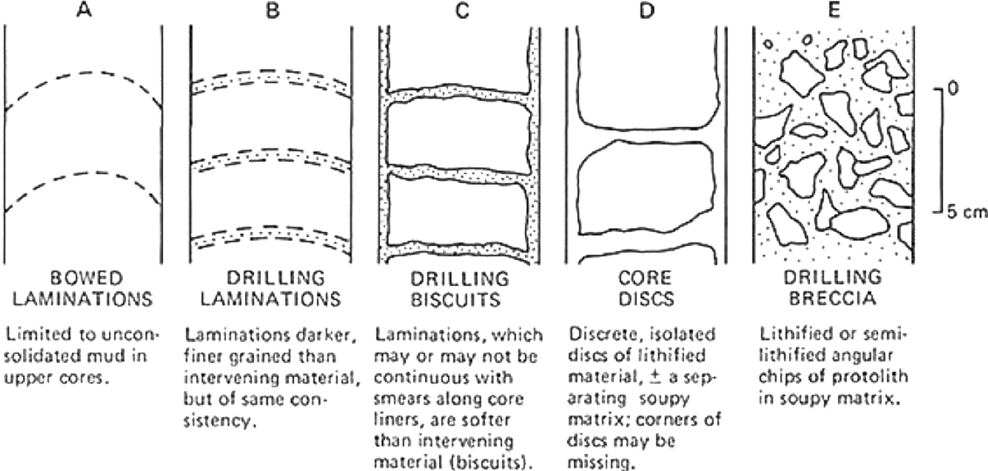
layering in the Millville and Wilson Lake B cores; hence, they suggested those cores too are disced.